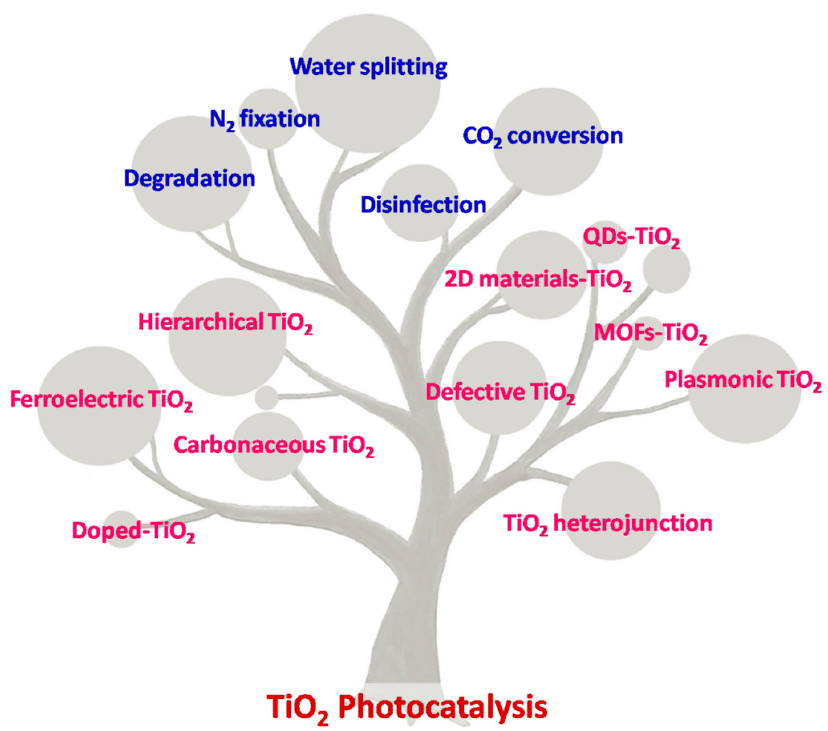
Figure 1. Overview of TiO 2 -based various photocatalytic systems and their applications.